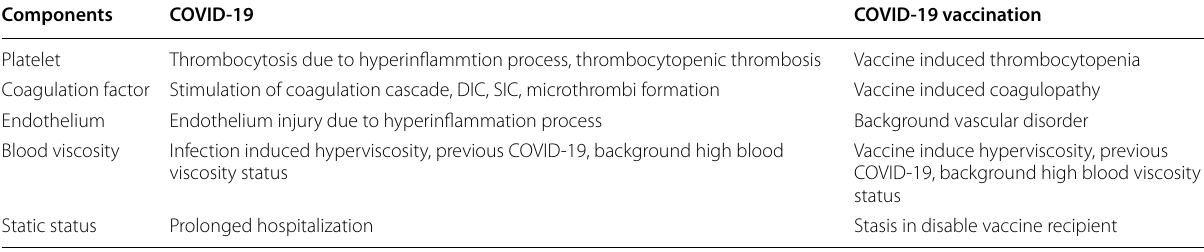
Table 1 Basic components stimulating neurovascular thrombotic disorder in COVID-19/COVID-19 vaccination